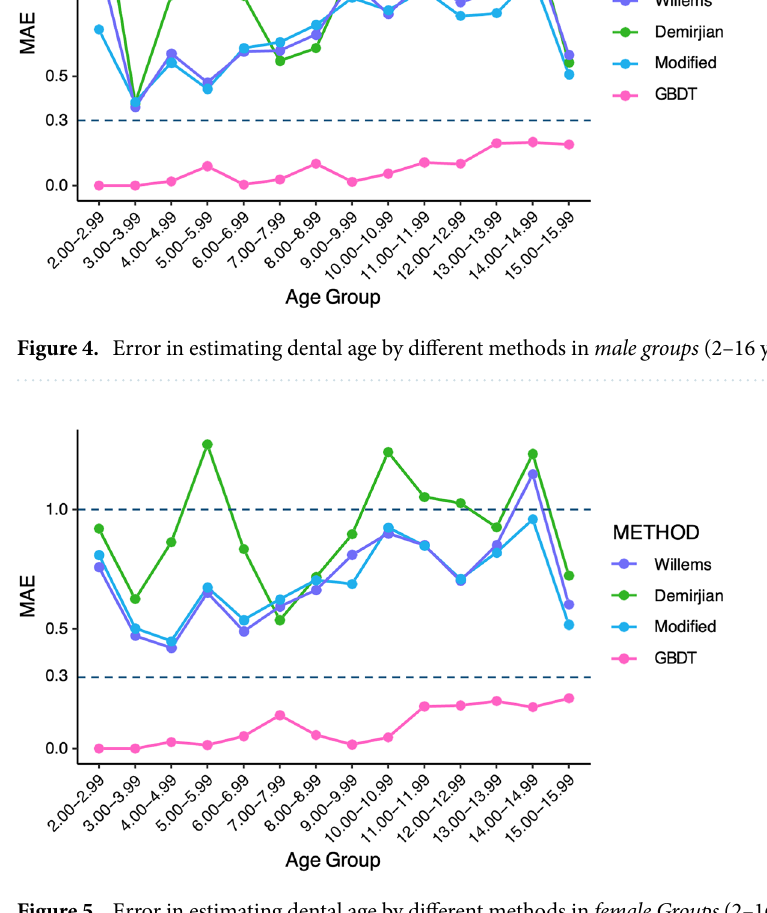
Figure 5. Error in estimating dental age by different methods in female Groups (2–16